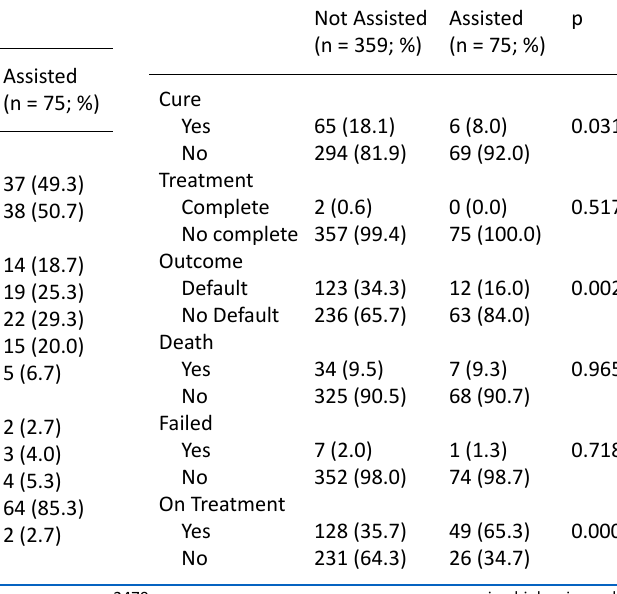
Table 3. Treatment outcome in DR-TB